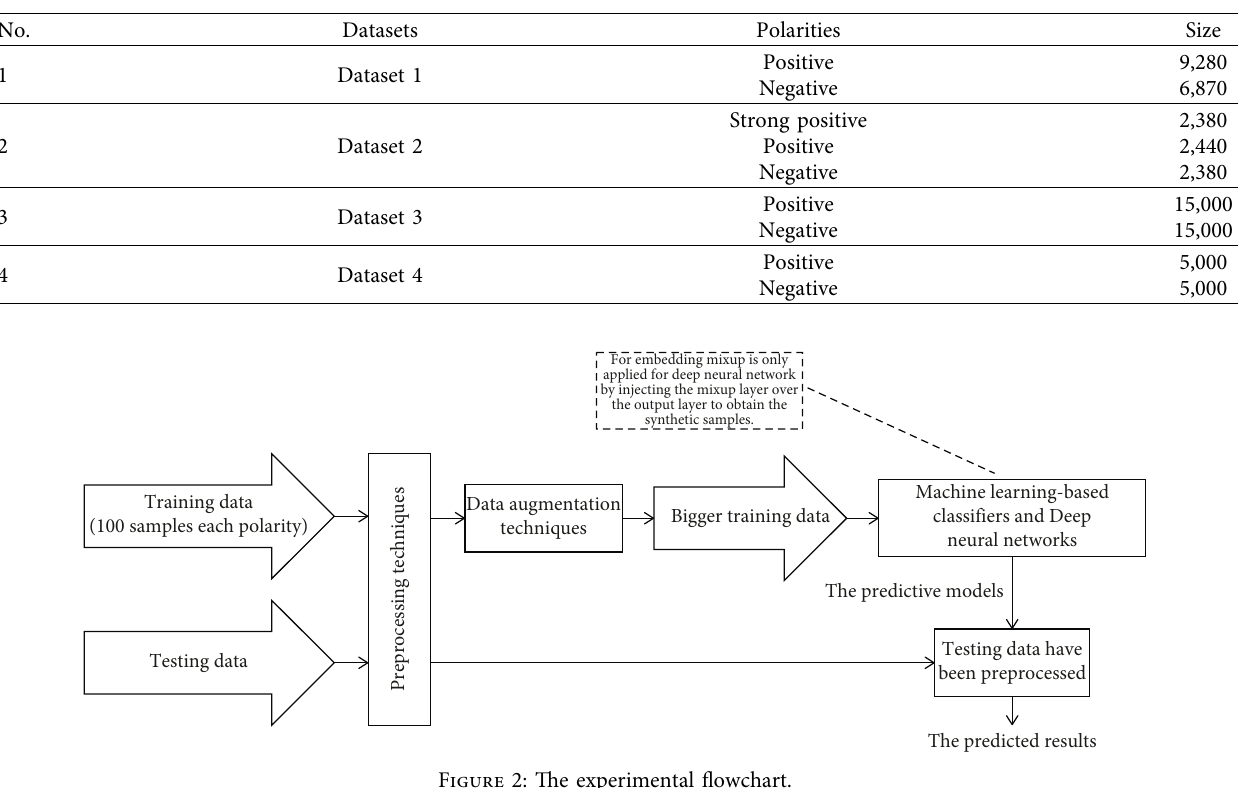
Table 1: The size of the